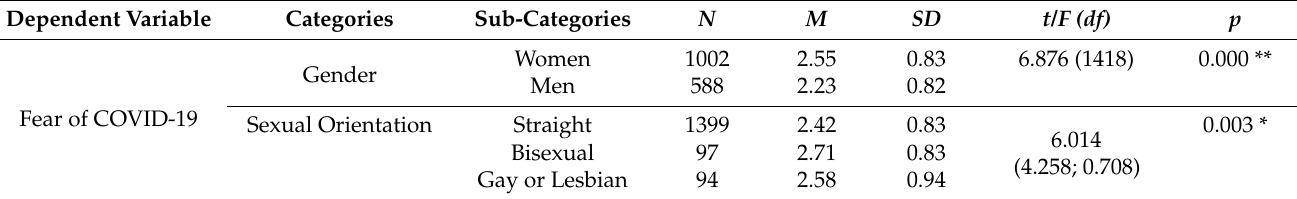
Table 4. Differences in Fear of COVID-19 by Gender and Sexual